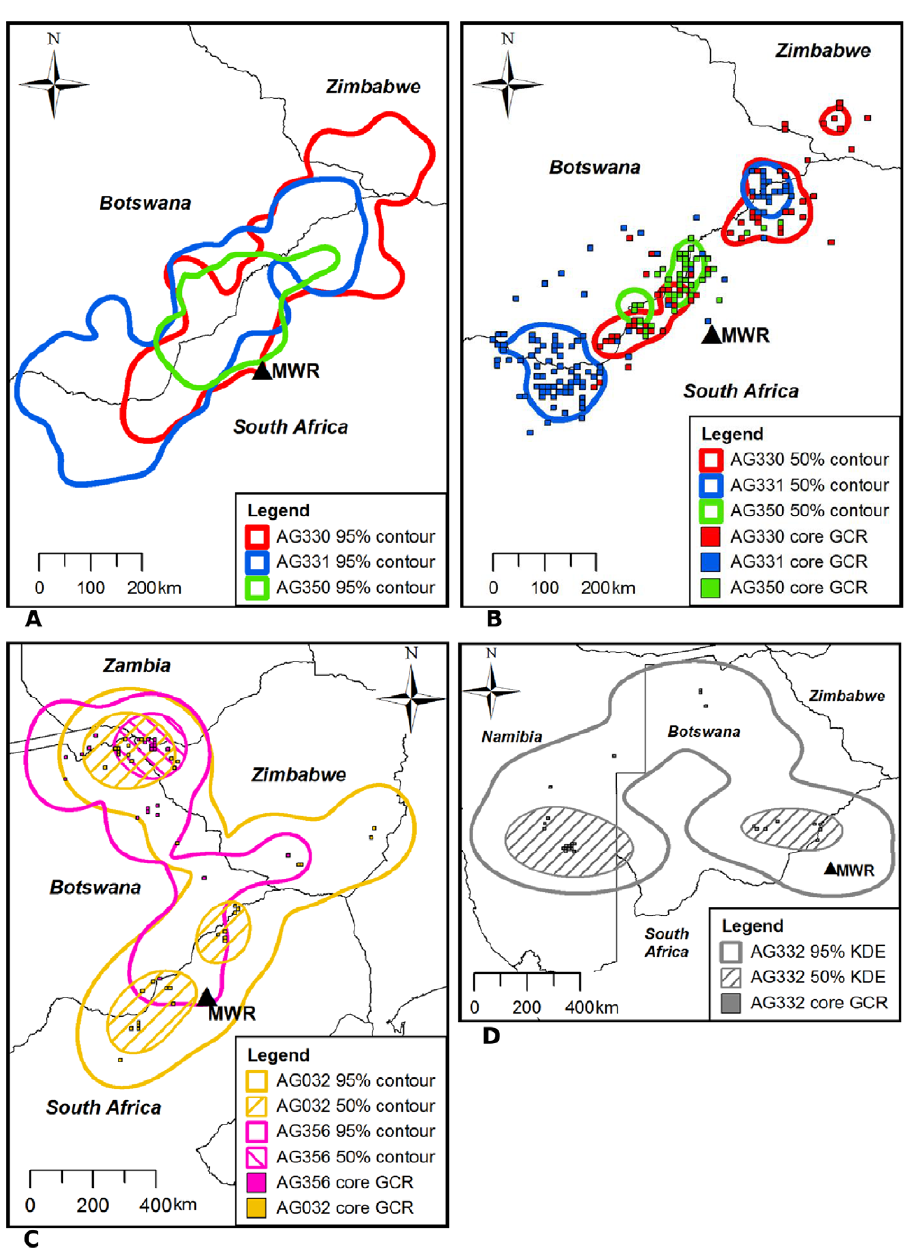
Figure 2. Overall and core foraging ranges for each individual. 95% KDE contours represent overall foraging ranges, 50% KDE contours and core GCRs represent core foraging ranges. (A) and (B) show the foraging ranges for AG330, AG331 and AG350; (C) shows the foraging ranges for AG032 and AG356; (D) shows the foraging ranges for AG332. Mankwe Wildlife Reserve capture site is indicated by a black triangle and ‘‘MWR’’. doi:10.1371/journal.pone.0052813.g002 At the overall foraging range scale Ivlev’s electivity index values their tracking periods either side of the South Africa-Botswana (Fig. S2A) indicated that more stationary GPS locations were border (AG330, AG331 and AG350), compared to 32.22 6 9.75% recorded inside protected areas than expected for three vultures, of the 95% KDE contours of the two vultures that travelled to while fewer than expected were recorded inside protected areas for northern Botswana and Zimbabwe (AG032 and AG356; Table 2). the other two. At the core foraging range scale Ivlev’s electivity index values (Fig. S2B) indicated that protected areas occupied a similar proportion of the 50% KDE contours to the 95% KDE contours for three of the vultures, but a smaller proportion of the 50% KDE contours than expected for the other two. Protected areas were completely absent from the 50% KDE contours of AG331 and AG350, compared to 38.62 6 11.63% for AG356 and